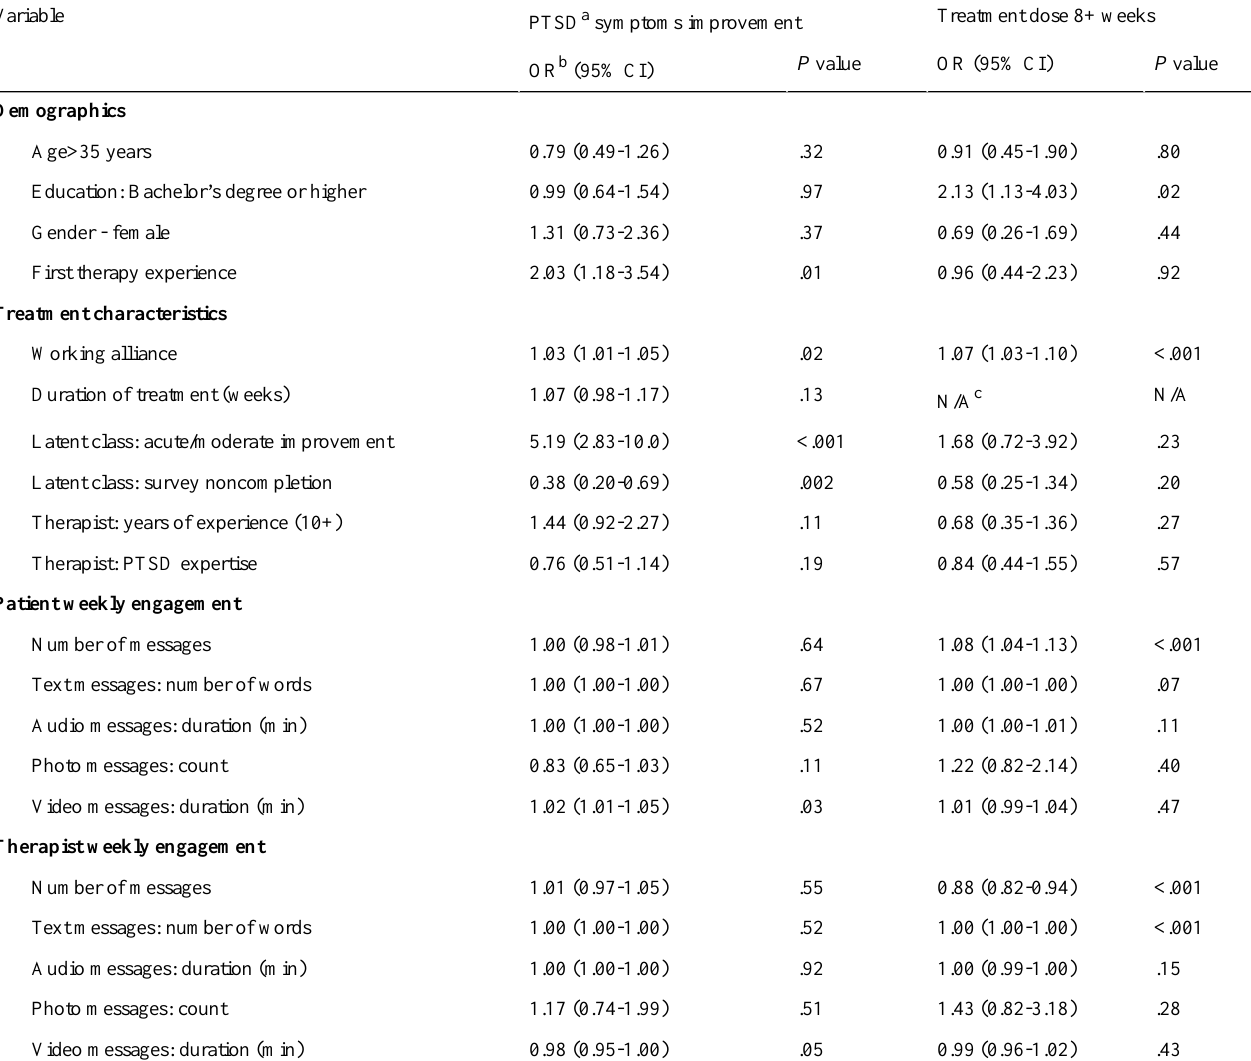
Table 3. Predictors of posttraumatic stress disorder symptoms clinically significant improvement and treatment adherence (N=475).